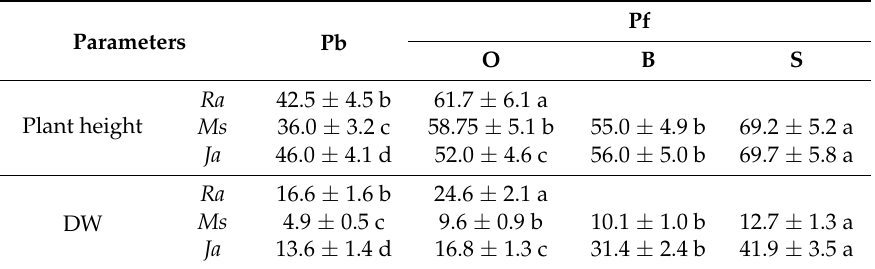
Table 2. Plant height (cm) and dry weight (DW) (g plant − 1 ) at the beginning (Pb) and at end of the experiment (Pf). O—open system, B—blended water system, and S—sequential reuse system. Data are the means ± standard deviation of four plants per treatment. Ra = Ruscus aculeatus , Ms = Maytenus senegalensis and Ja = Juncus acutus . Averages within a file with the same letters are not significantly different at p < 0.05 (ANOVA and LSD test).